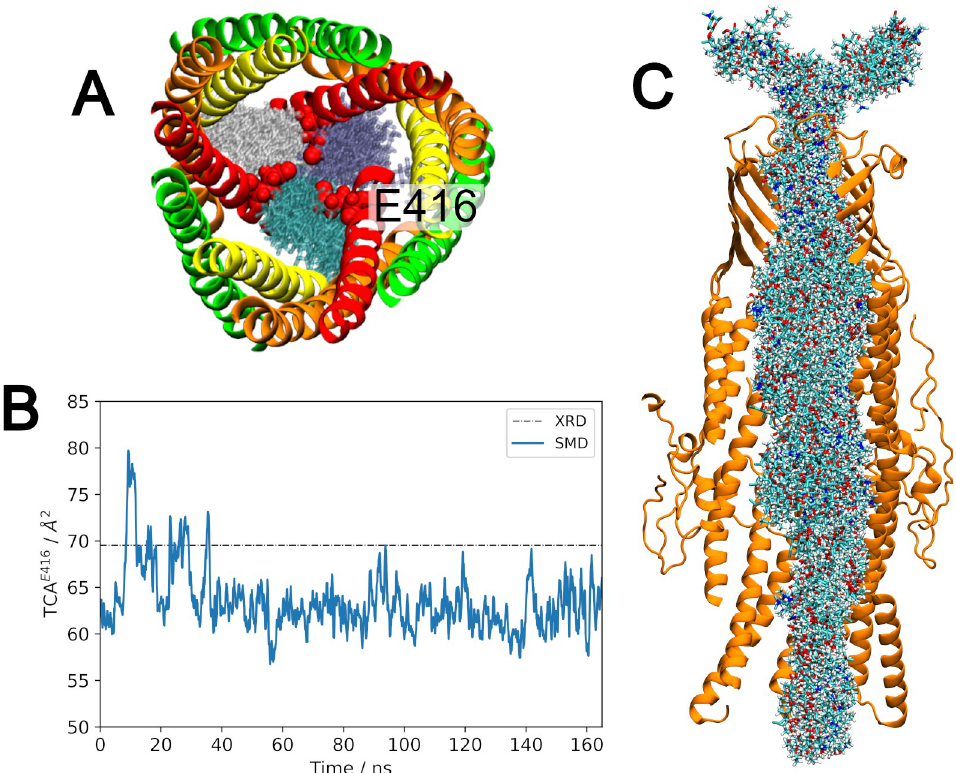
Fig 10. Translocation of Erythromycin through CmeC. (A) Entry of erythromycin (shown as overlaid white, purple, and cyan transparent structures) occurs between the coiled-coil helices (shown in red, orange, green, and yellow New Cartoon representation) rather than through the central constriction defined by the side chains of the E416 residues (shown in red VDW). This entry pathway is also observed for CDCA. (B) Timeseries of the triangular cross-sectional area defined by the C α atoms of the three E416 residues (TCA E416 ). Erythromycin enters the channel within the first 35 ns, which disrupts the coordination of E416 residues to the central calcium ion, causing the protomers to move apart and the TCA to increase. When erythromycin has passed this constriction region the TCA returns to a value below that in the x-ray structure as multiple E416 residues coordinate the central calcium ion. (C) Cutaway of CmeC (orange New Cartoon representation) with every 5 th frame for erythromycin (licorice, coloured by atom name) from three replicates overlaid. Hydrogen atoms not shown for clarity. Erythromycin displays no clear orientation preference on